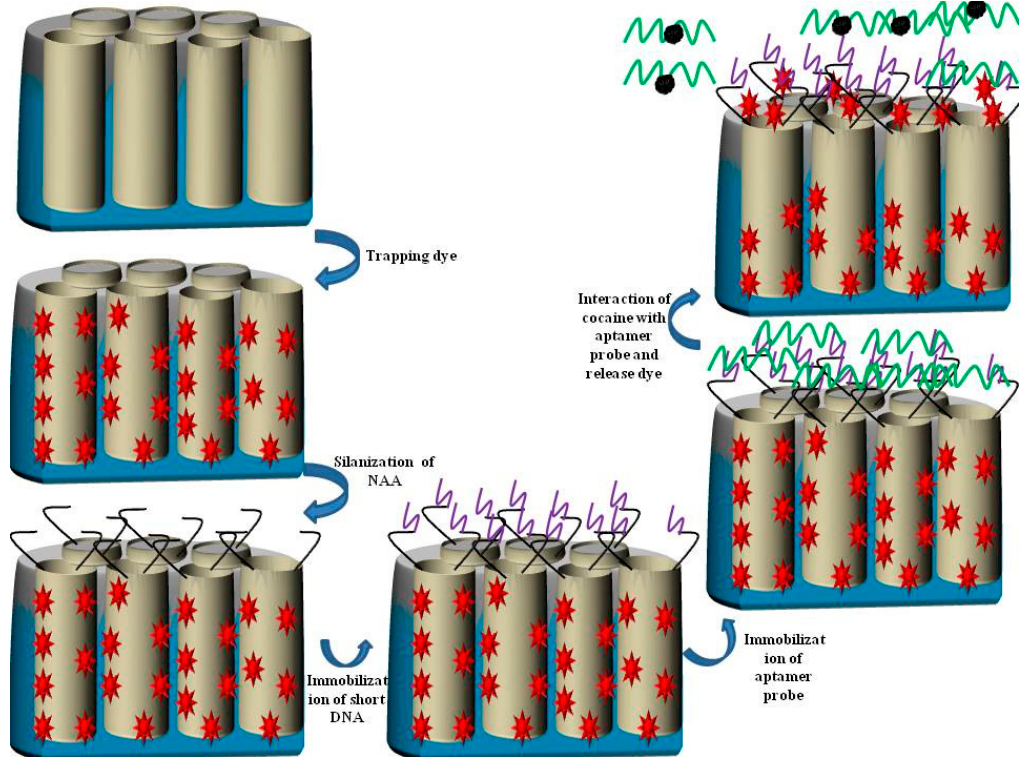
Figure 6. Schematic representation of the fabrication of the NAA-short chain aptamer/aptamer probe for the determination of cocaine using photoluminescence spectroscopy (PLS).